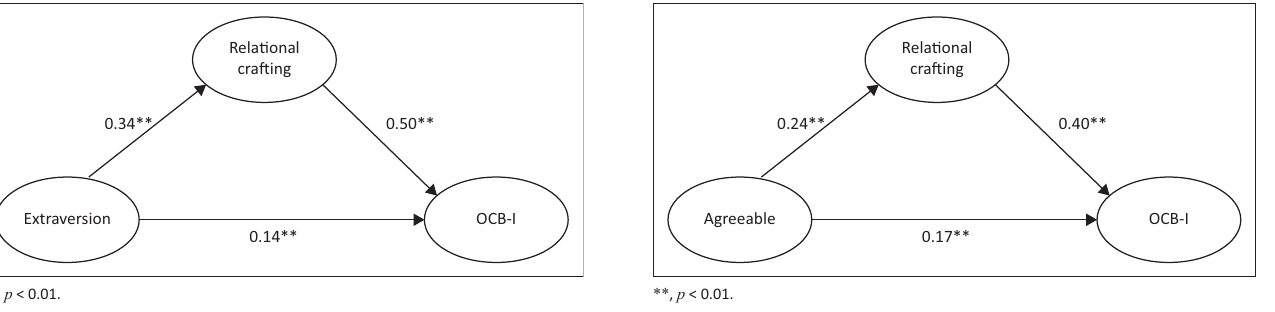
FIGURE 2: Path diagram between extraversion, relational crafting and organisational citizenship behaviour-I.